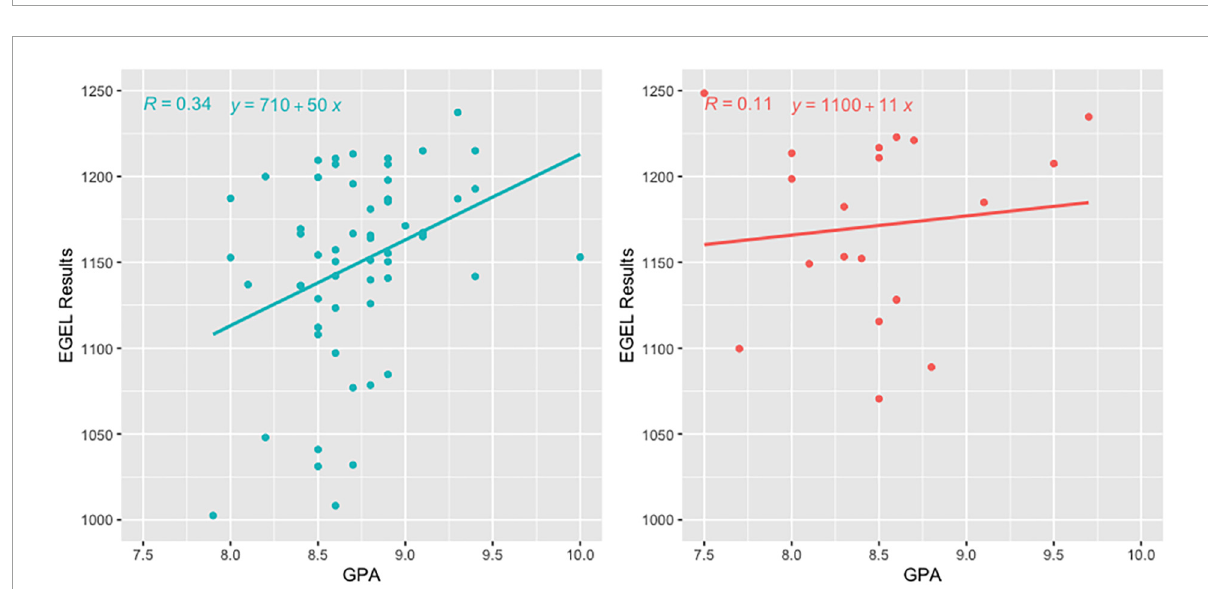
FIGURE6 EGEL (General graduation Exam by the National Centre of Evaluation) results and GPA comparison by gender. The correlation coefficients for women and men are 0.34 and 0.11, respectively (Blue–Women; Red–Men).